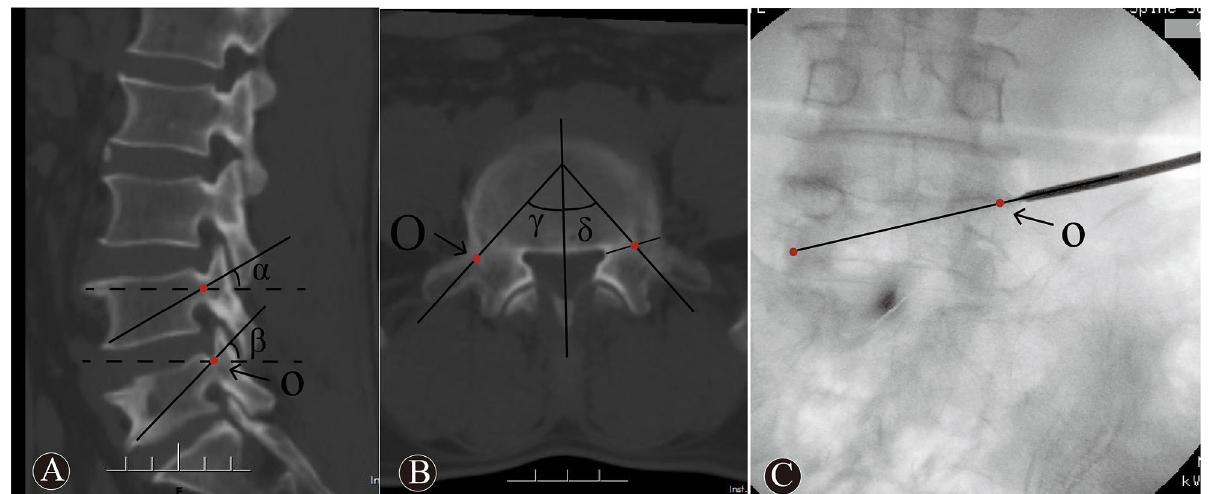
Figure 1. Images showed the puncture approach via point “O” and TPA. The sagittal CT image ( A ) was showed that α and β were sagittal puncture angle of T-PKP and O-PKP, respectively. The cross-sectional CT image ( B